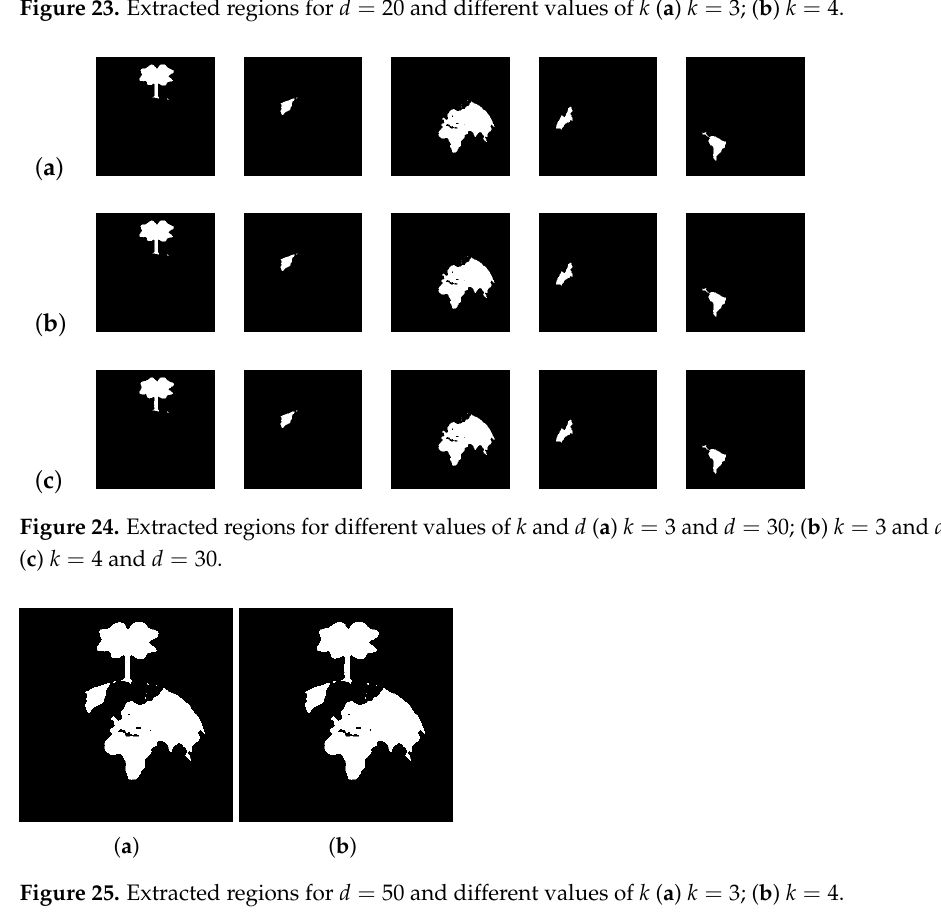
Figure 23. Extracted regions for d = 20 and different values of k ( a ) k = 3; ( b ) k = 4.